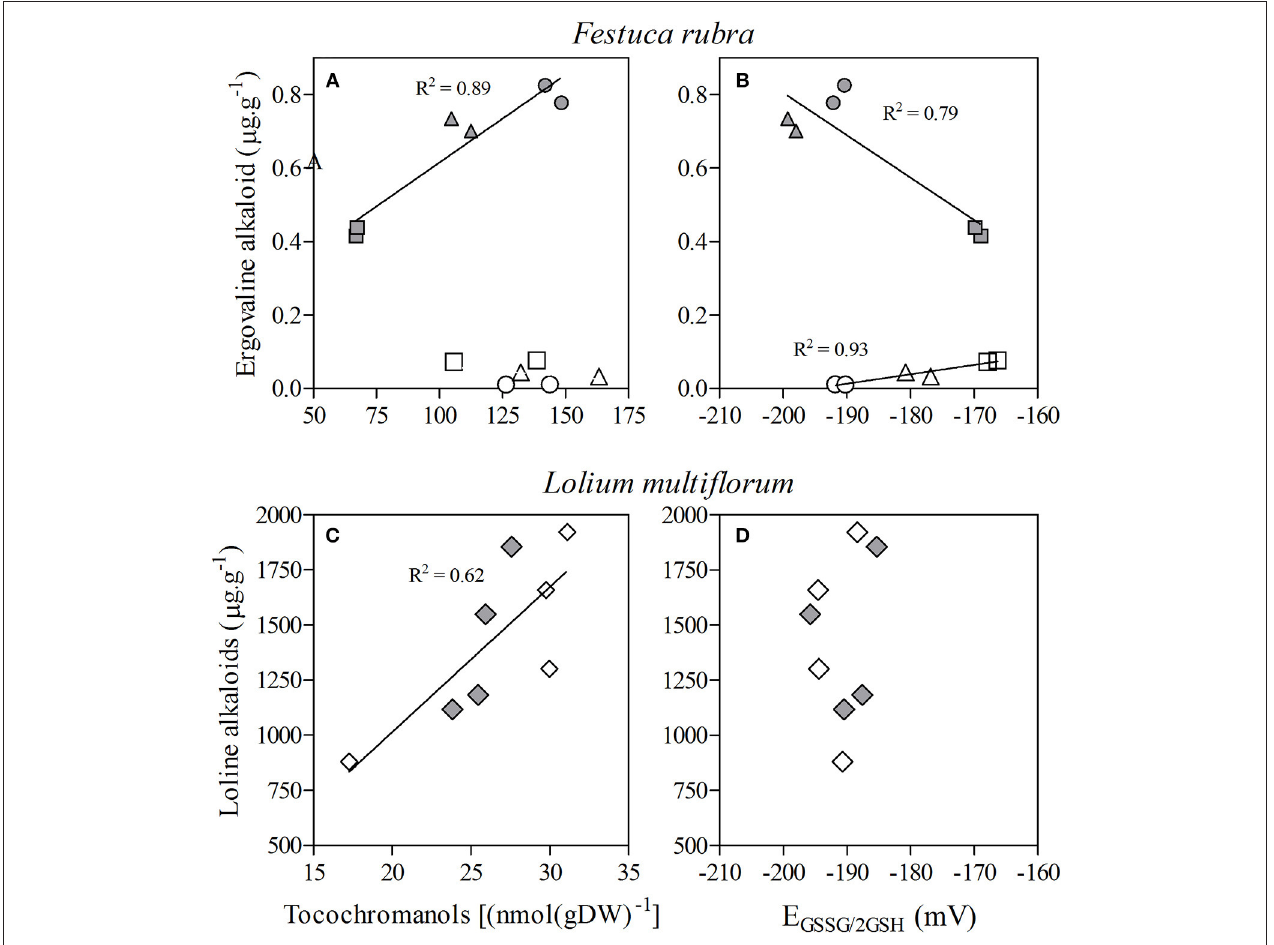
FIGURE 1 | (Upper) Relationship between the concentration of the alkaloid ergovaline and antioxidant (total) tocochromanols (A) and the glutathione half-cell reduction potential (E GSSG / 2GSH ) (B) in seeds of two maternal lines (PEN and RAB, white and gray symbols, respectively) of Festuca rubra symbiotic with the fungal endophyte Epichloë festucae , produced in three different years: 2009 (squares), 2010 (circles), and 2011 (triangles). Regression lines and coefficient of determinations are only shown when significant ( P < 0.05) and are calculated for a given data set (e.g., RAB). (Lower) Relationship between the concentration of loline alkaloids and antioxidant (total) tocochromanols (C) and the glutathione half-cell reduction potential (E GSSG / 2GSH ) (D) in seeds produced by Lolium multiflorum plants symbiotic with the fungal endophyte Epichloë occultans exposed to high ( ≈ 120 ppb, gray diamonds) or low ( < 10 ppb, white diamonds) ground-level ozone. Since there was no effect of ozone, the regression line and coefficient of determination correspond to the whole data set and is significant at P < 0.05.